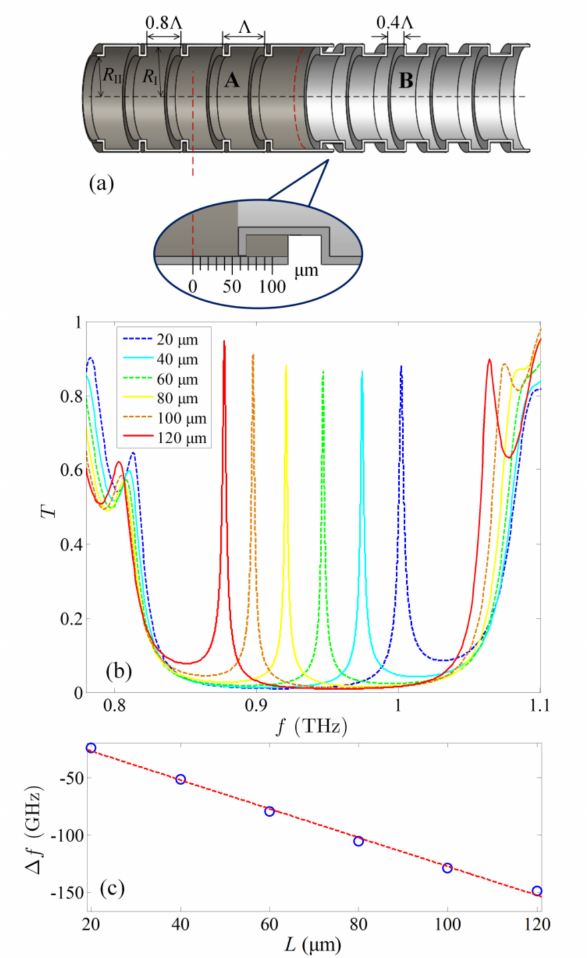
Figure 3. The THz micro–nano displacement sensor and its sensing performance. ( a ) Structure diagram of the hetero-structure waveguide sensor. The dark and light gray parts are Waveguides A and B, respectively. The red dashed line denotes the zero-displacement point and the inset is a magnification of the shifting structure with scales. ( b ) Transmitted peaks for the di ff erent displacements according to the scales. ( c ) Peak frequency shifting with increasing